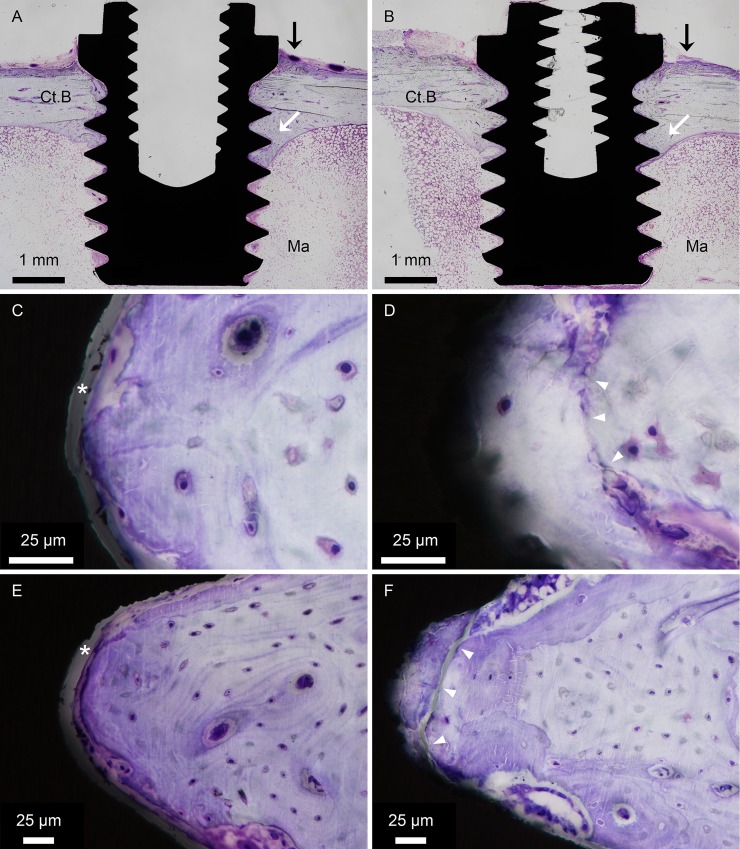
Histology.Undecalcified toluidine blue-stained sections of the (A) machined and (B) laser-modified implants. Both types of implants are vertically and unicortically positioned in the tibia. The two upper threads are located in the original cortical bone (Ct.B). Endosteal bone downgrowth (white arrows) is observed, extending downwards to the level of the third/fourth thread, whereas the remaining threads are mainly located in the bone marrow (Ma) compartment. Occasionally, periosteal bone formation (black arrows) is observed, reaching up to the implant flange yet remaining below the level of the cover screw. Bone interfacing the (C, E) machined and (D, F) laser-modified implants, at the level of the upper cortical thread (C-D) and the level of the endosteal threads (E-F). For the machined implants, a separation is frequently detected (white asterisk) between bone and implant. The laser-modified surface revealed bone in direct contact. For all laser-modified implants, fracture lines (white arrowheads) were observed in the bone within the threads at short distances (typically 30–50 μm) from the implant surface and running parallel to the implant surface in the thread valley.